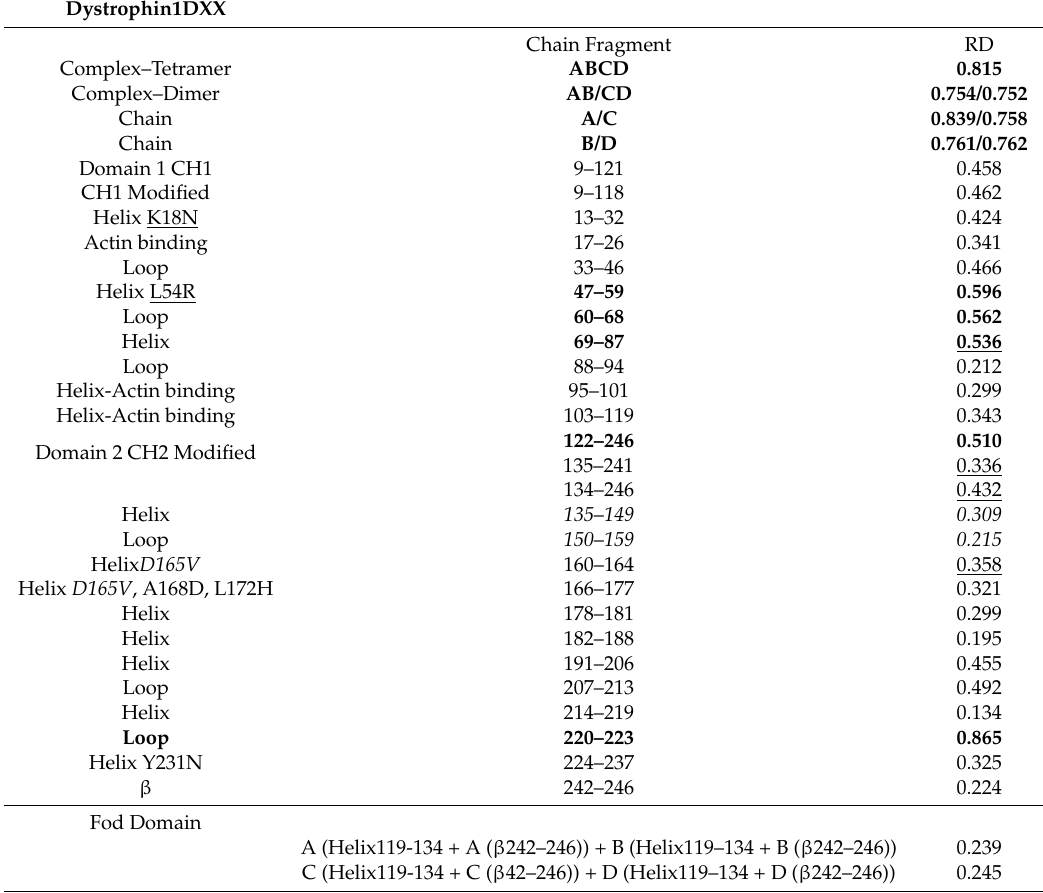
Table 6. RD values calculated for the ABCD complex, for AB and CD subcomplexes, for a single chain and for individual domains (CH1, CH2) of dystrophin (1DXX), as well as for selected secondary structural folds. “FOD DOMAIN” represents fragments contributed by two chains (A,B) which form a coherent domain with its own FOD-compliant hydrophobic